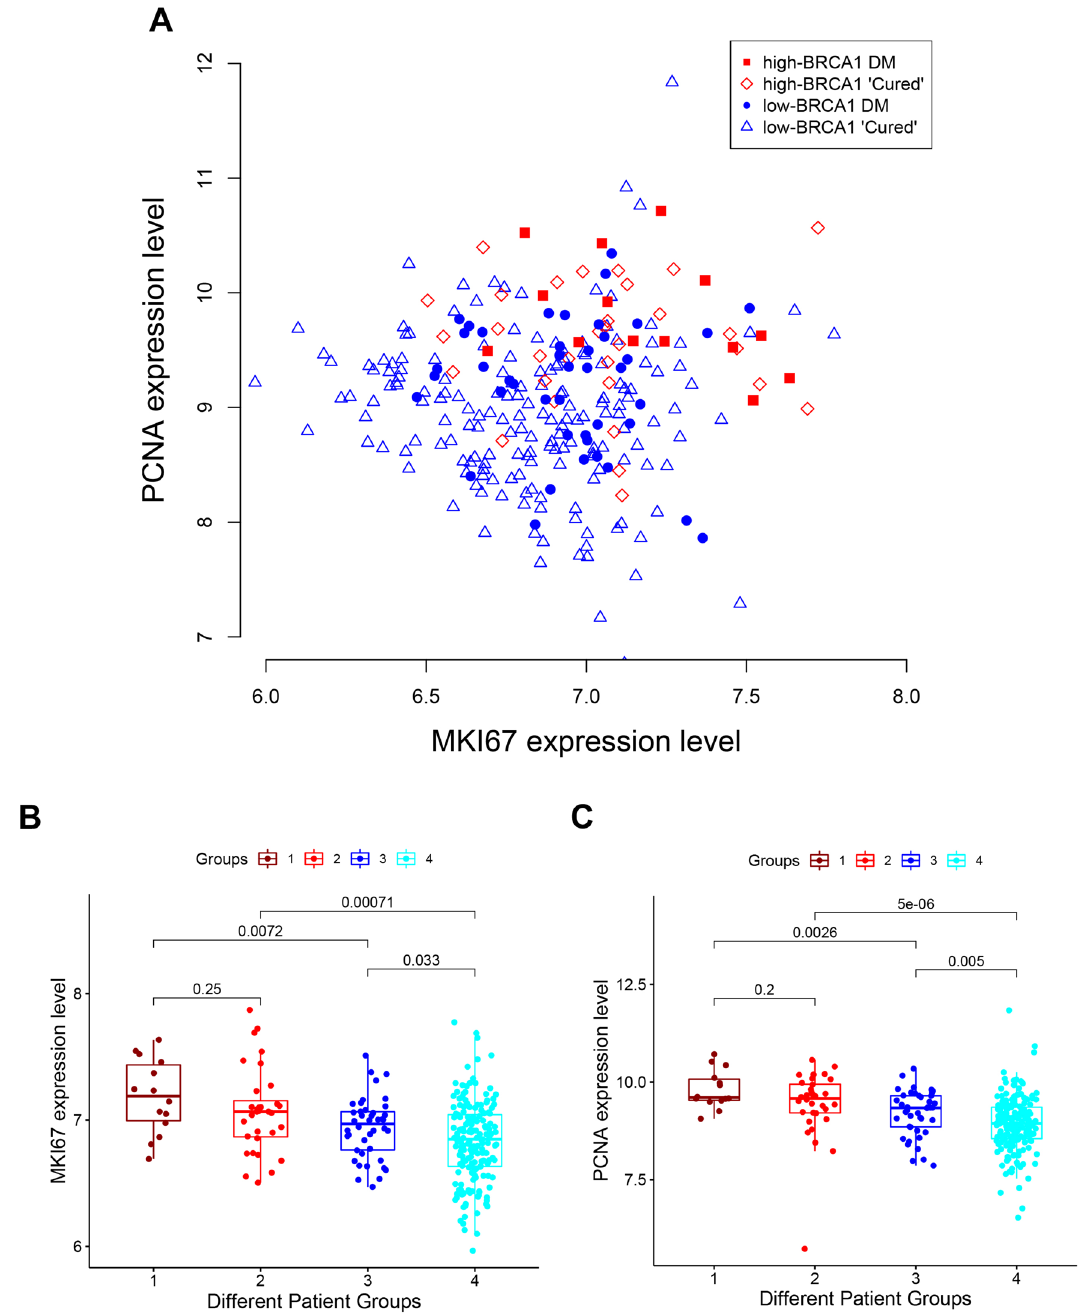
Figure 5. MKI67 and PCNA expression in 359 tamoxifen-treated patients. ( A ) Scatterplot of MKI67 and PCNA expression levels for 4 groups of patients. ( B ) Boxplot of MKI67 expression in 4 groups of patients. ( C ) Boxplot of PCNA expression in 4 groups of patients. 1 = High BRCA1 patients with DM, 2 = High BRCA1 “cured” patients (i.e., without DM and follow-up longer than 5.77 years), 3 = Low BRCA1 patients with DM, 4 = Low BRCA1 “cured” patients ( i.e., without DM and follow-up longer than 5.77